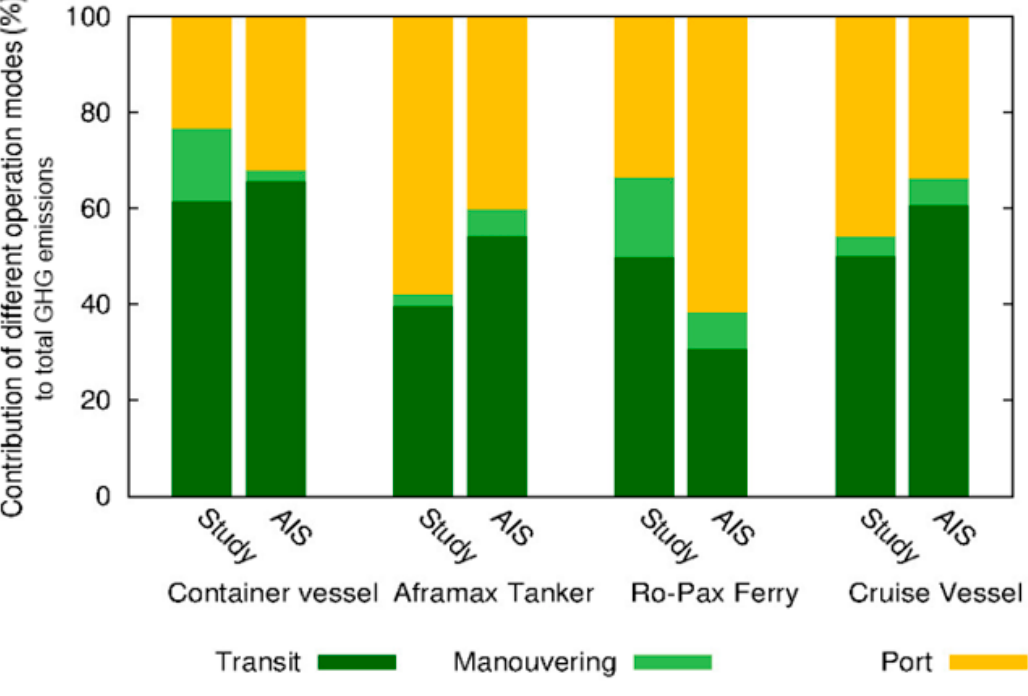
Figure 12. Comparison of operational profiles from AIS and case studies.